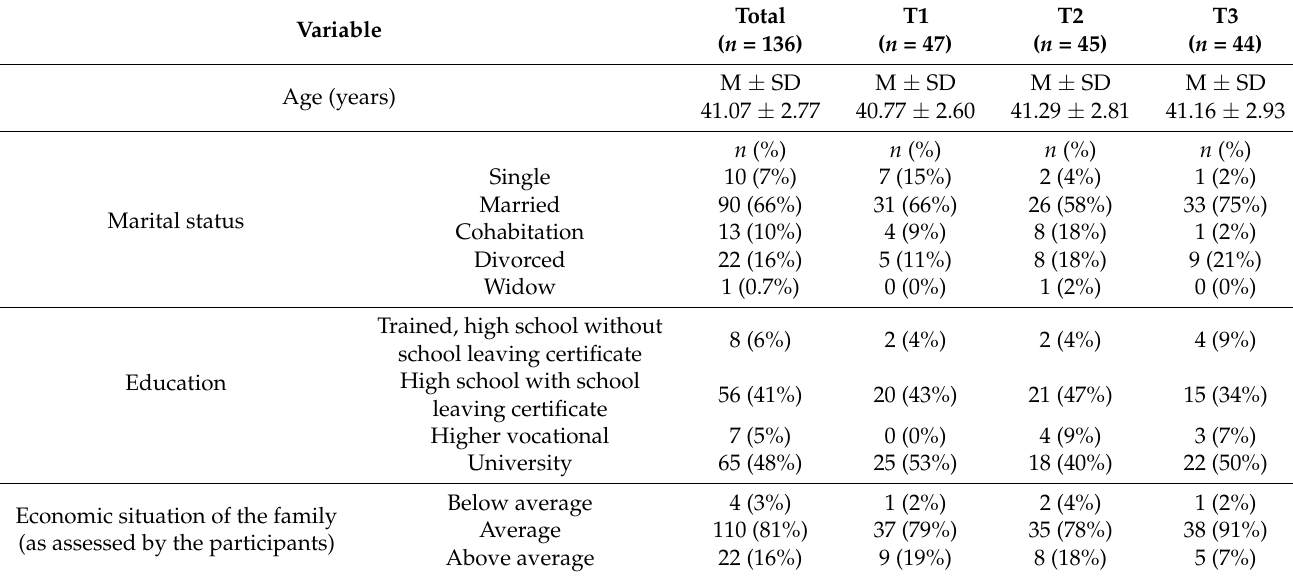
Table 2. Demographic characteristics of the sample.